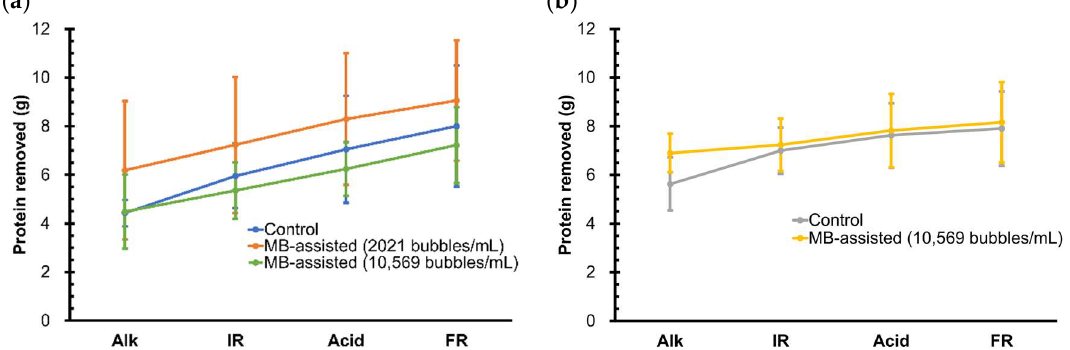
Figure 3. Effect of MB incorporation on the cumulative amount of protein removed over the CIP process operated at a flow rate of ( a ) 130 L/min and ( b ) 190 L/min. Alk: alkaline wash; IR: intermediate rinse, Acid: acid wash; FR: final rinse. All test groups were not significantly different from their respective control groups.